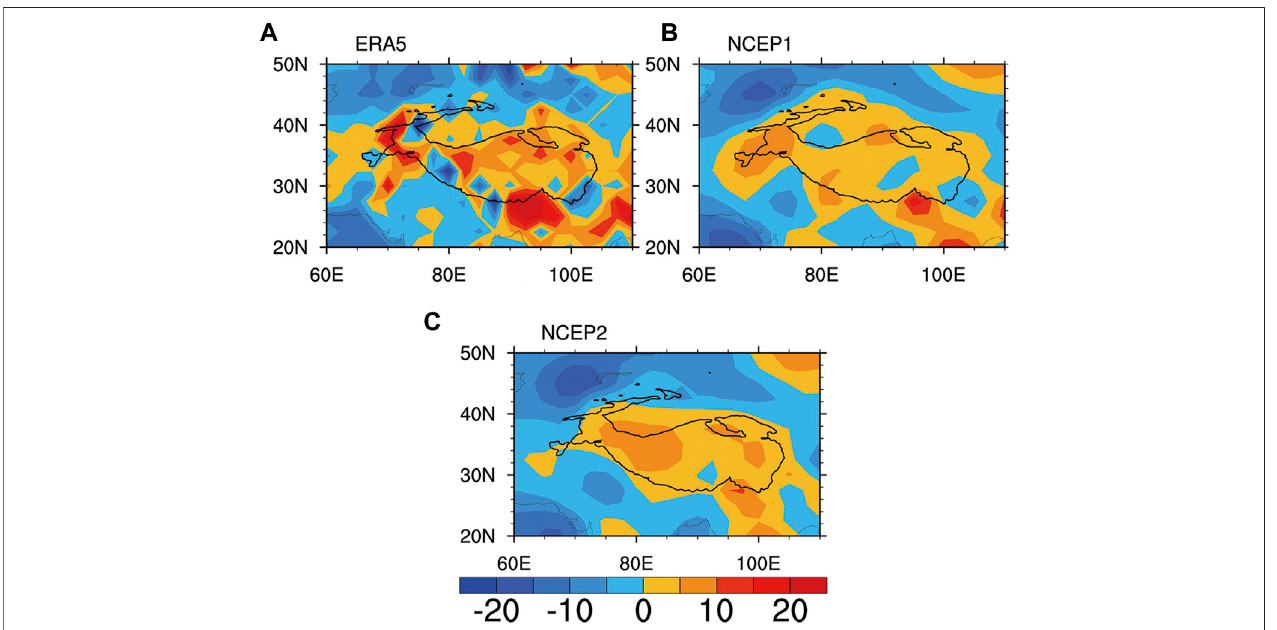
FIGURE1| Climatologyoftheverticallyintegrated(fromthelandsurfaceto100 hPa)atmosphericapparentheatsourceinspring(colorshading;units:W m − 2 )over theQTPand itssurrounding areasfrom 1979to2020basedthethreereanalysisdatasets: (A) ERA5, (B) NCEP1and (C) NCEP2. Theblack linesrepresent the3,000 m altitude contours.